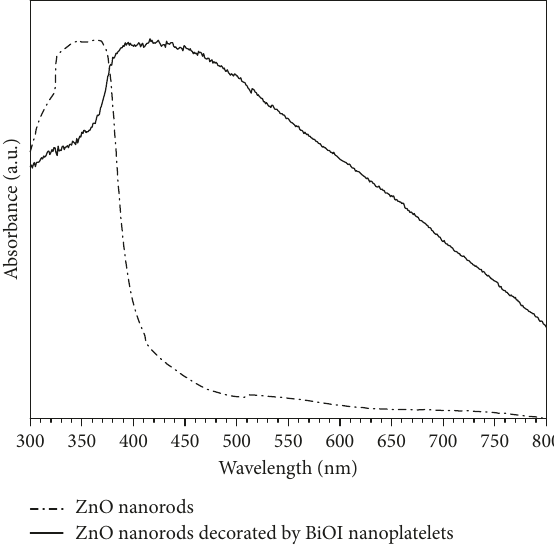
Figure 7: Absorbance spectra of ZnO-NR and ZnO-NR decorated by